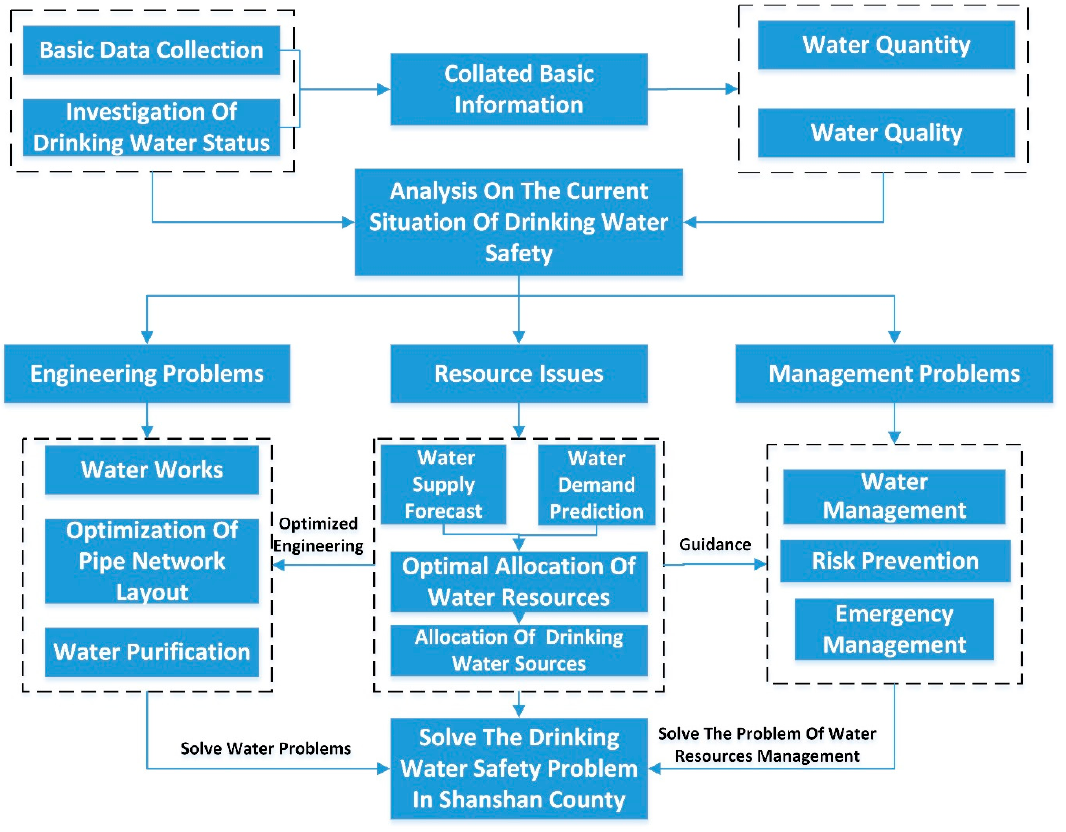
Figure 2. Technical route of the study methods.